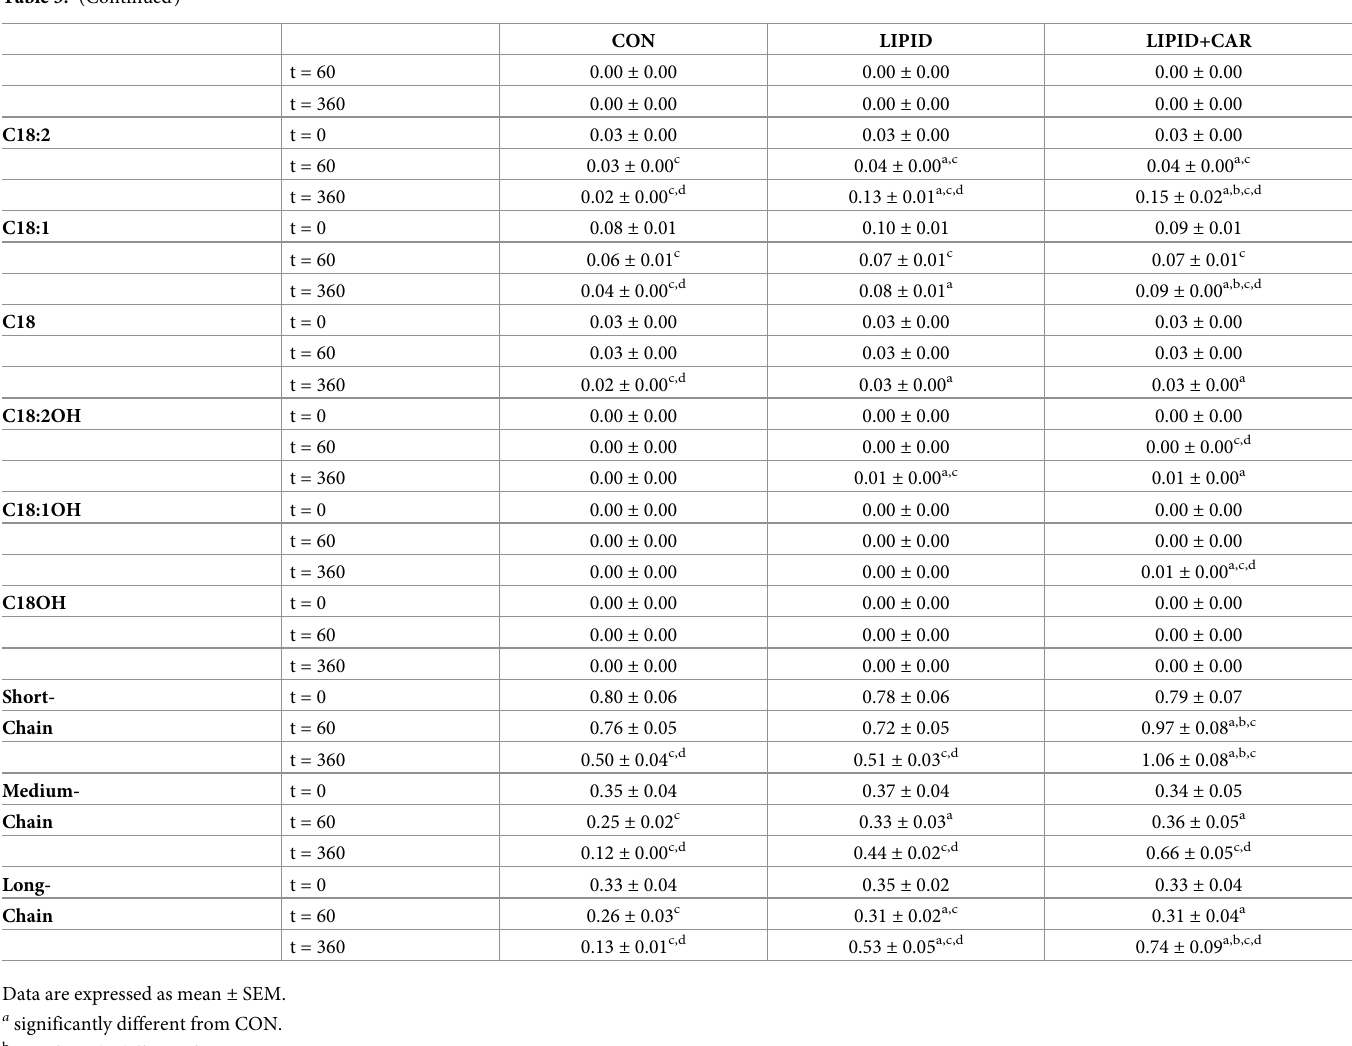
L-carnitine infusion already increased plasma free carnitine availability to supra-physiological concentrations (155 ± 5 μ mol/L, P < 0.01) and finally reaching concentrations of 183 ± 6 μ mol/L ( P < 0.01) after six hours of infusion (Fig 4A and Table 3). No changes from baseline in plasma free carnitine availability were observed in the CON and LIPID trial over time ( P > 0.99, Fig 4A and Table